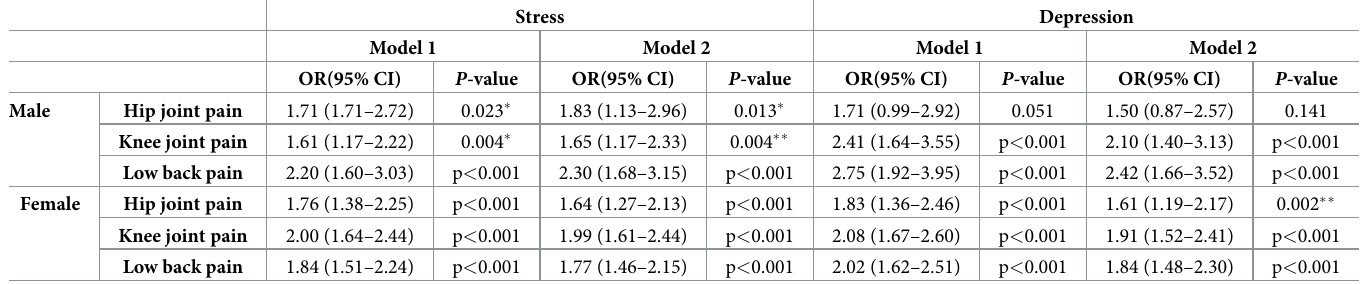
Table 3. Association between mental health and OA pain site using multiple logistic regression analysis.